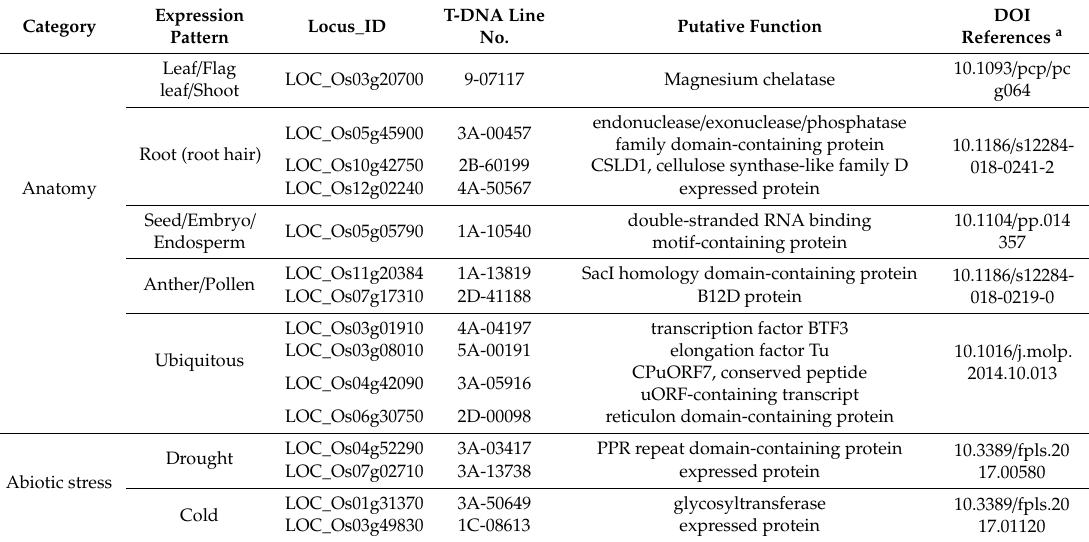
Table 1. Summary of promoter trap lines identified by GUS